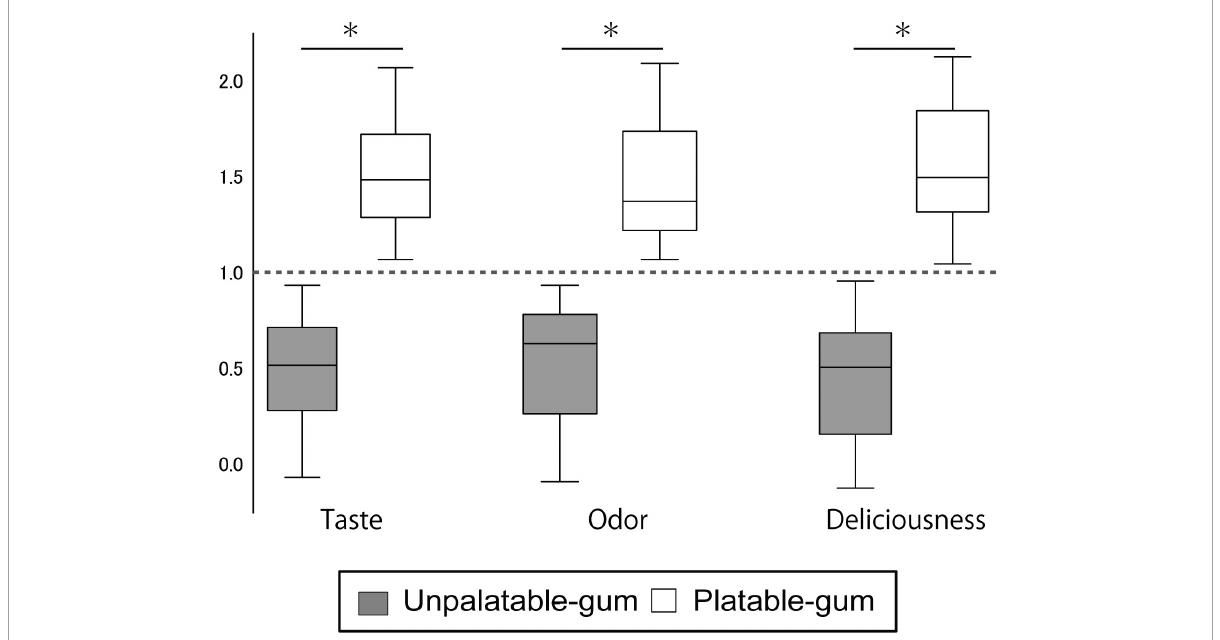
FIGURE3 Results of sensory testing. The Y-axis scale shows the sensory testing results. Data for each gum were calculated using the following formula. Palatable gum = X/{(X + Y)/2}, Unpalatable gum = Y/{(X + Y)/2}; where X: VAS of palatable gum, Y: VAS of unpalatable gum. ∗ Indicates a significant difference between unpalatable gum and palatable gum (paired t -test, P <